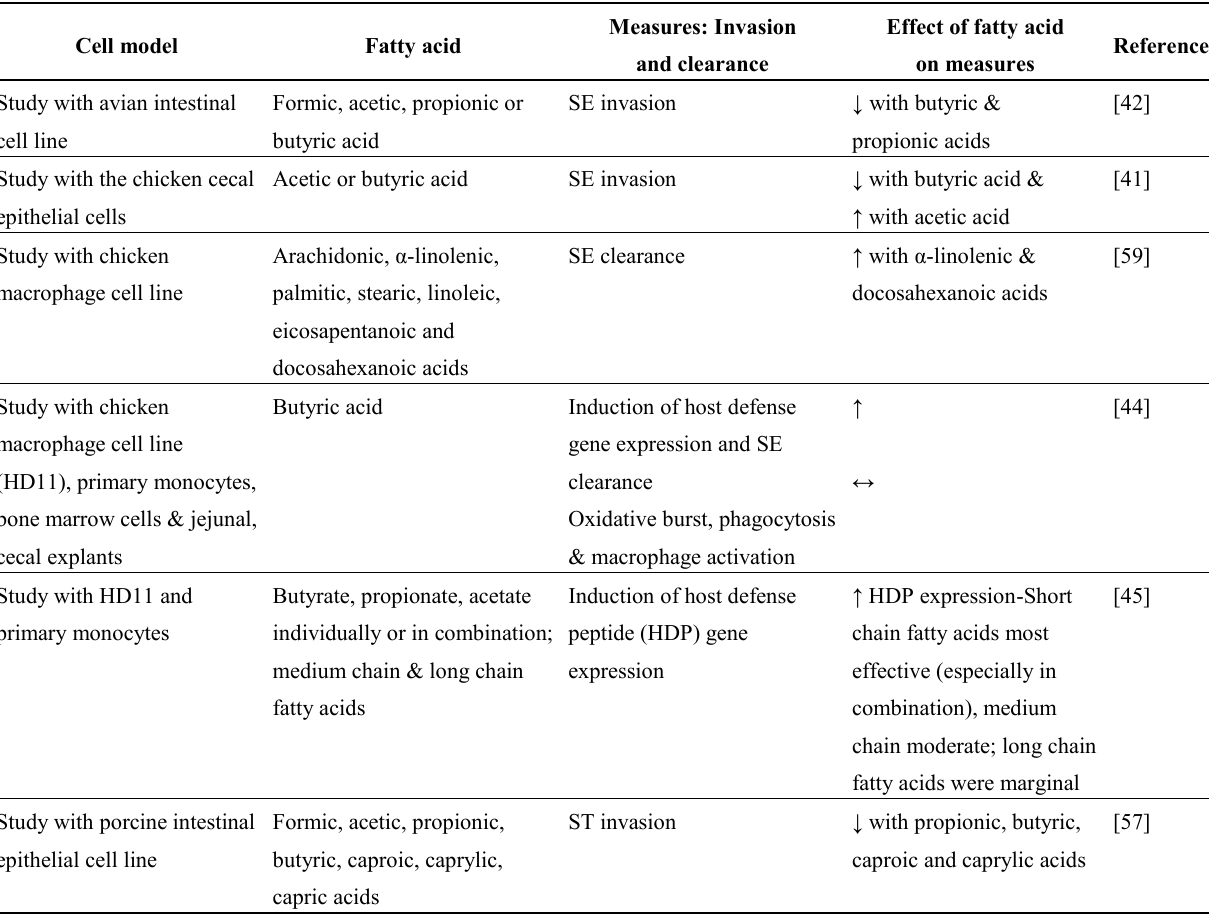
Table 2. In vitro studies: Impact of dietary fatty acids on Salmonella invasion and